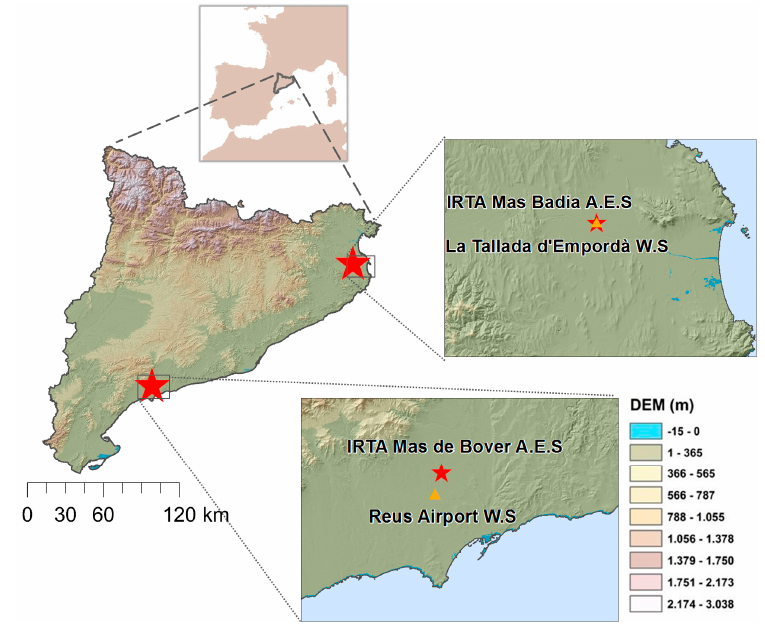
Figure 1. Location of the two IRTA (Institute of Agrifood Research and Technology) Agricultural Experimental Stations (AES, red star) and the weather stations (WS, orange triangle) where flowering